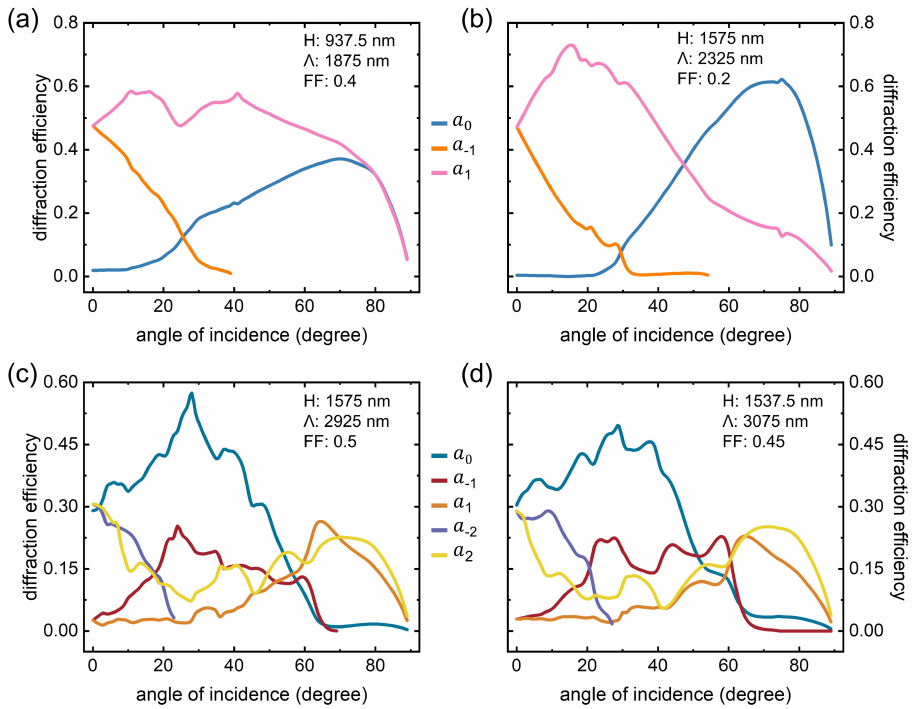
Figure 4. Binary grating diffraction efficiencies under varied incident angles. ( a – d ) Four parameter combinations, as values of H, Λ , and FF are suggested in the